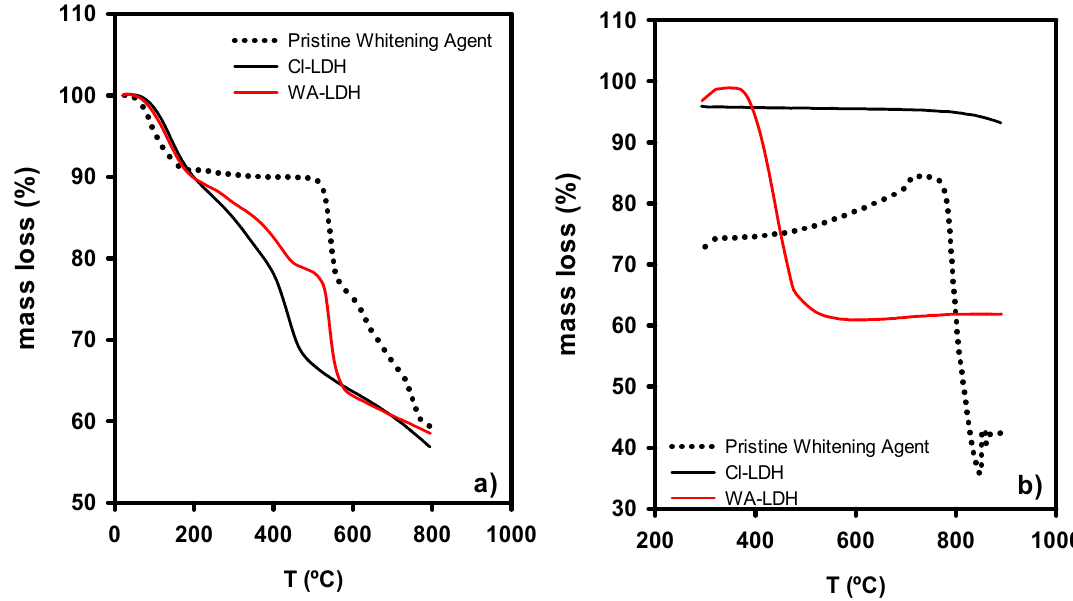
Figure 2. Thermogravimetric analysis of the whitening agent and the modified LDHs under inert atmosphere ( a ) and a subsequent oxygen atmosphere heating ( b